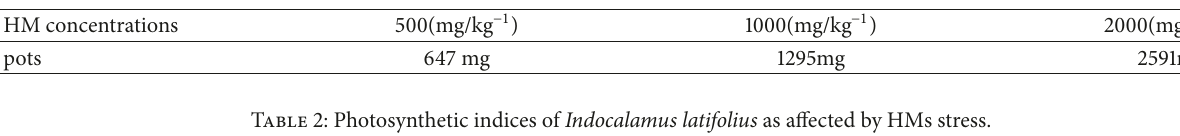
Table 1: HM concentrations in pots.